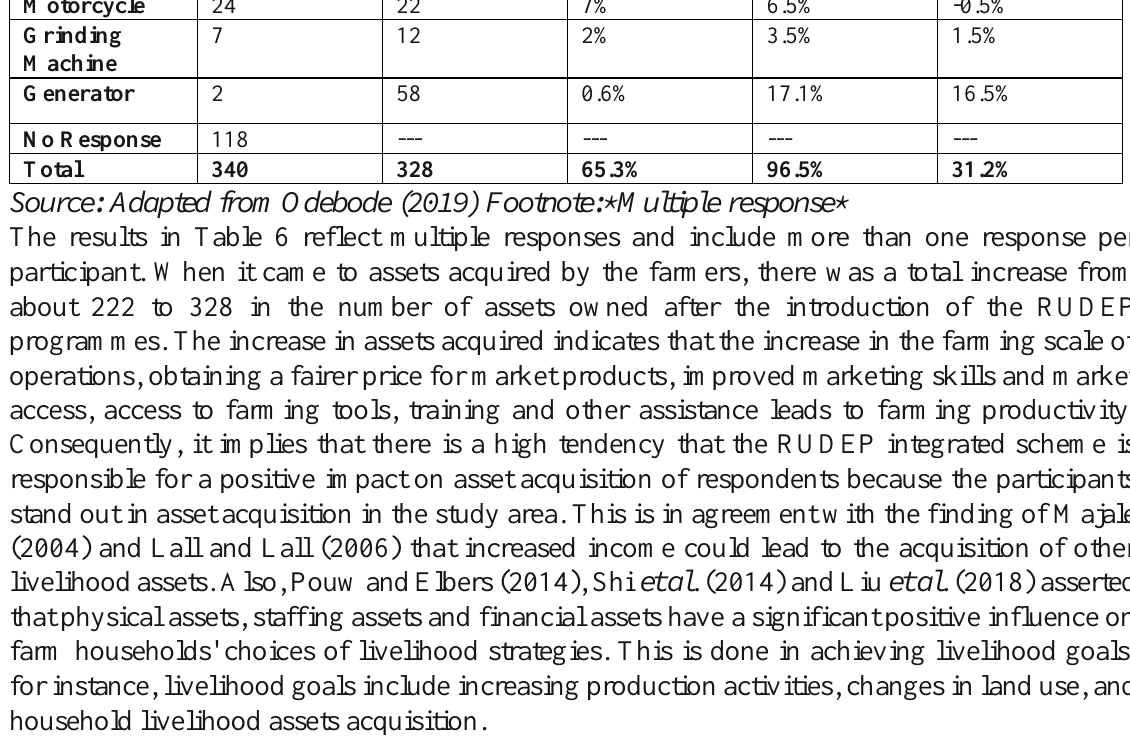
Table 7: Increase in Housing